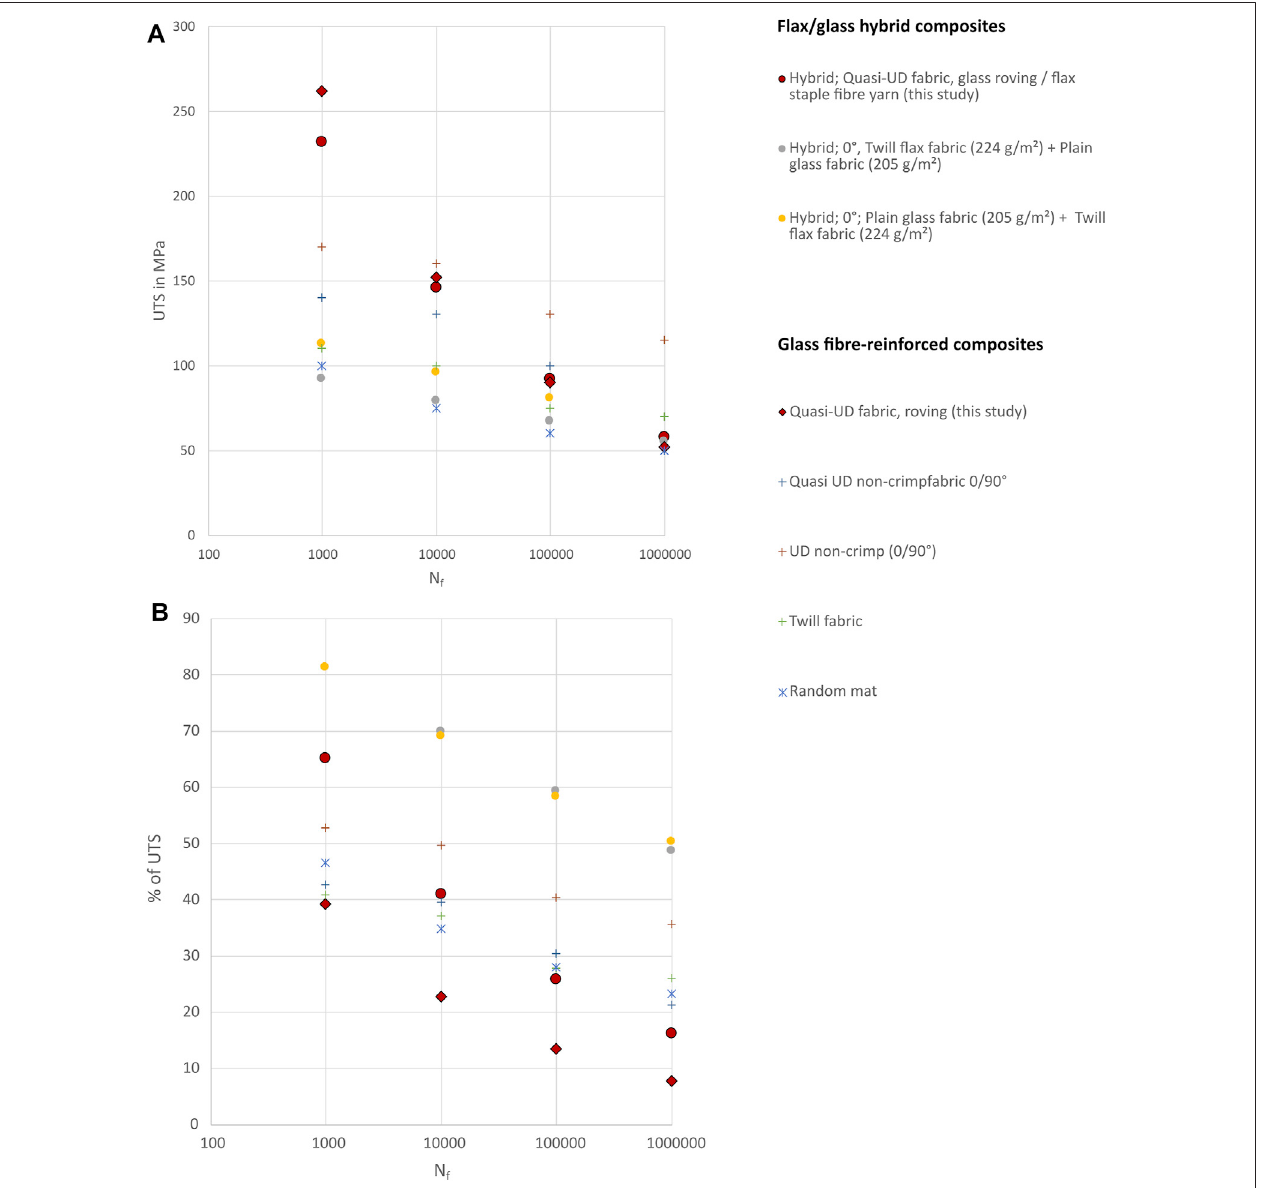
FIGURE 10 | Comparison of hybrid ( fl ax/glass) and glass in the literature (red circles and diamonds are the results of our test series); (A) the absolute strength is presented; (B) the percentage strength in relation to the static strength is shown. In the percentage representation, our hybrid shows clear advantages compared with GFRP. The data were summarized in revised form from (Liang et al., 2012; Asgarinia et al., 2015; Bensadoun, 2016).